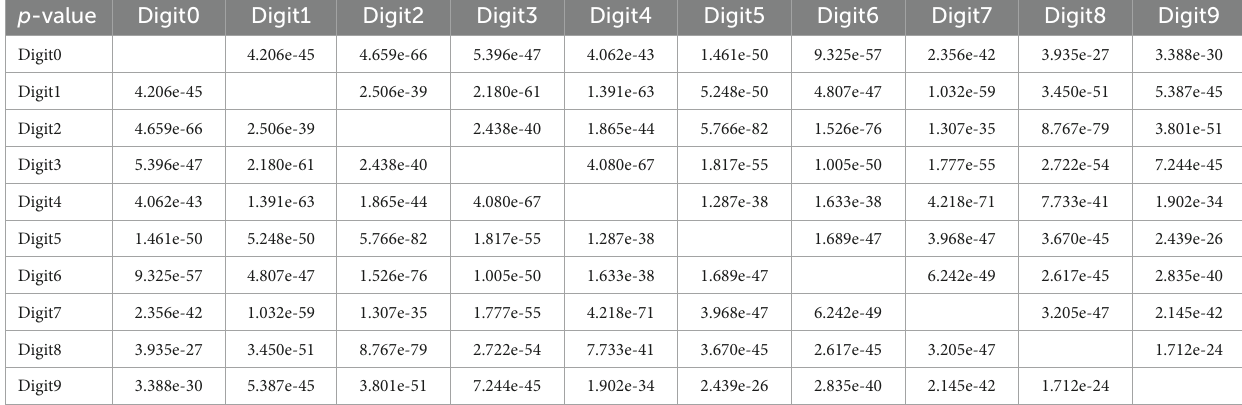
TABLE 1 p -values for Hotelling’s T-square tests that show differences between all collective reservoir states corresponding to different digit